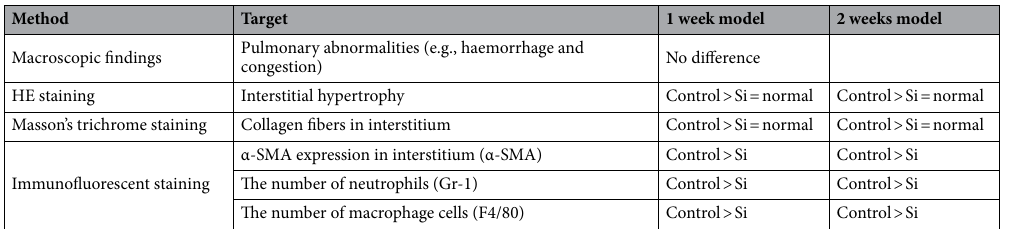
Table 1. Analytical comparison results of Con-IP and Si-IP